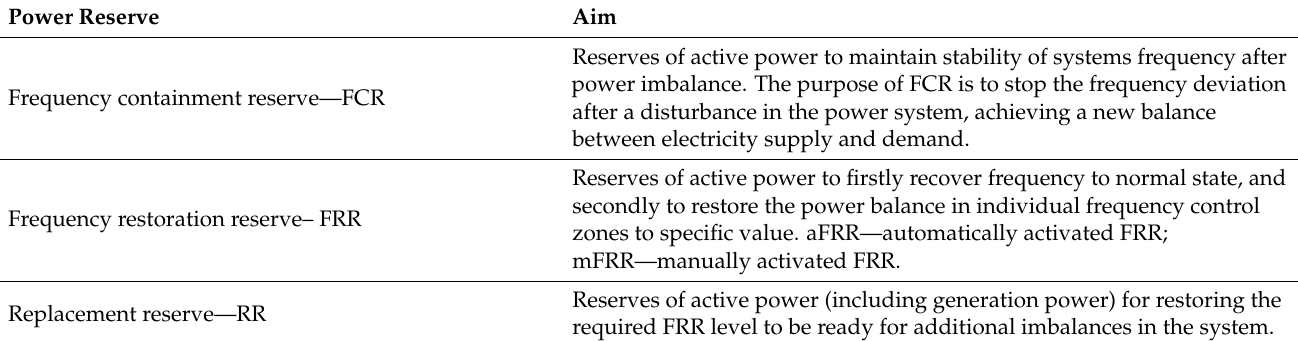
Table 1. Active power reserves in the Continental Europe Synchronous